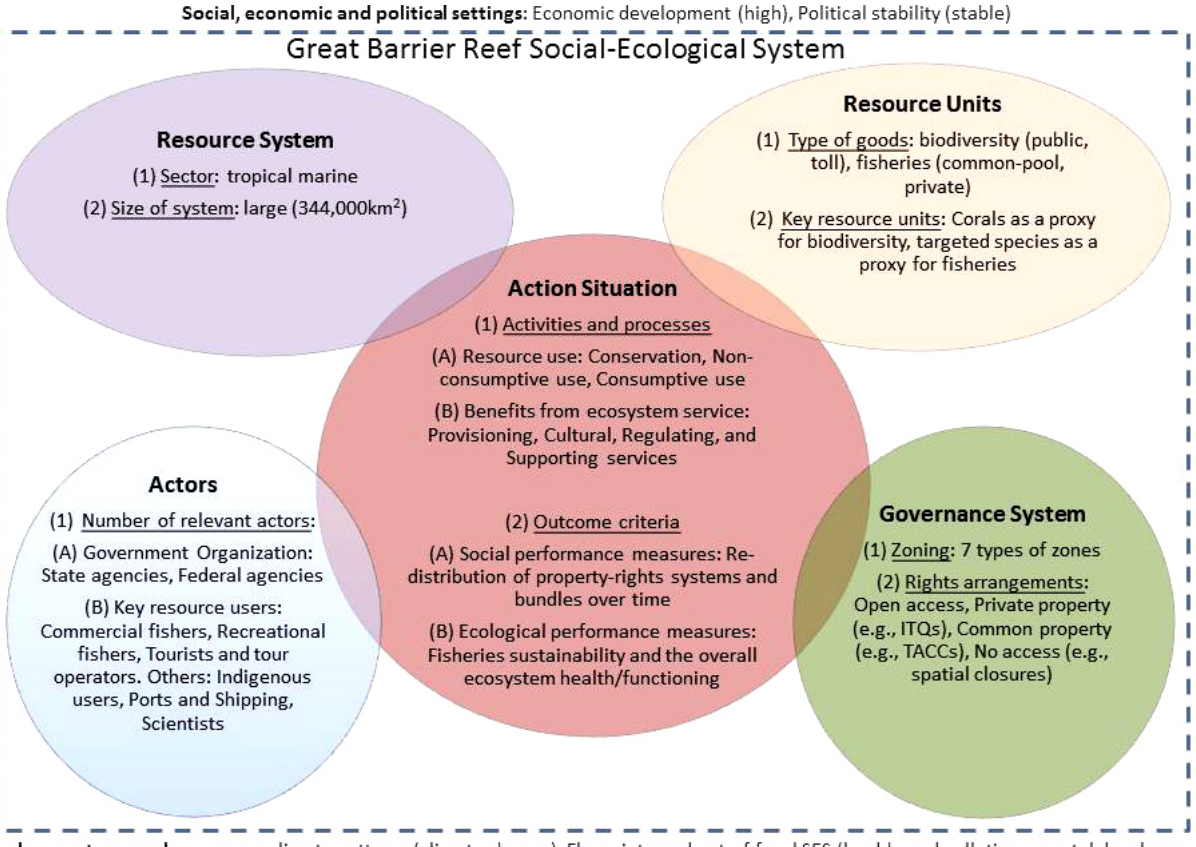
Fig. 3. Key components of the social-ecological system framework included in this study. Based on McGinnis (2011), Basurto (2013), and McGinnis and Ostrom